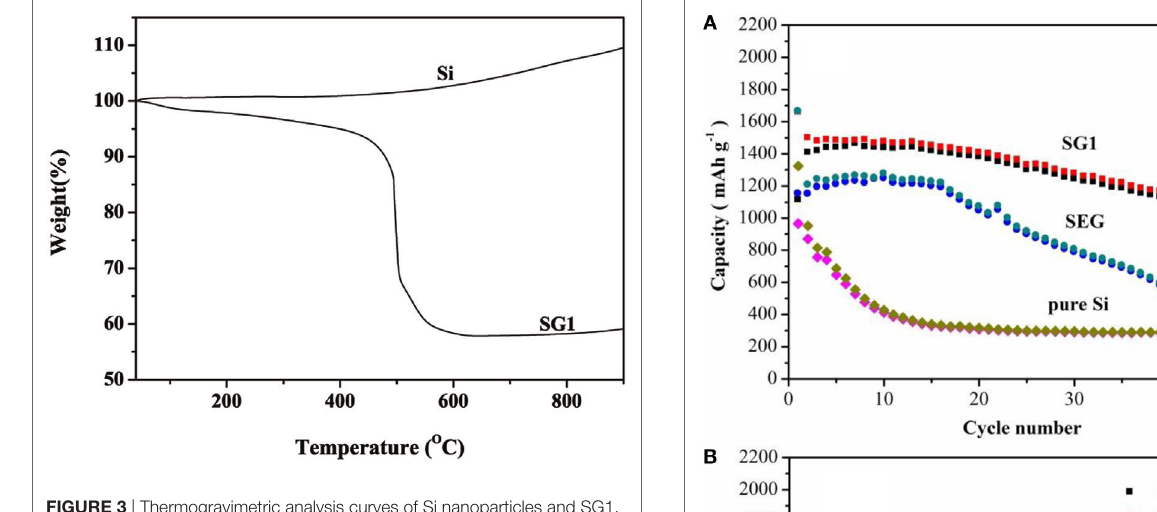
FigUre 3 | Thermogravimetric analysis curves of Si nanoparticles and SG1.